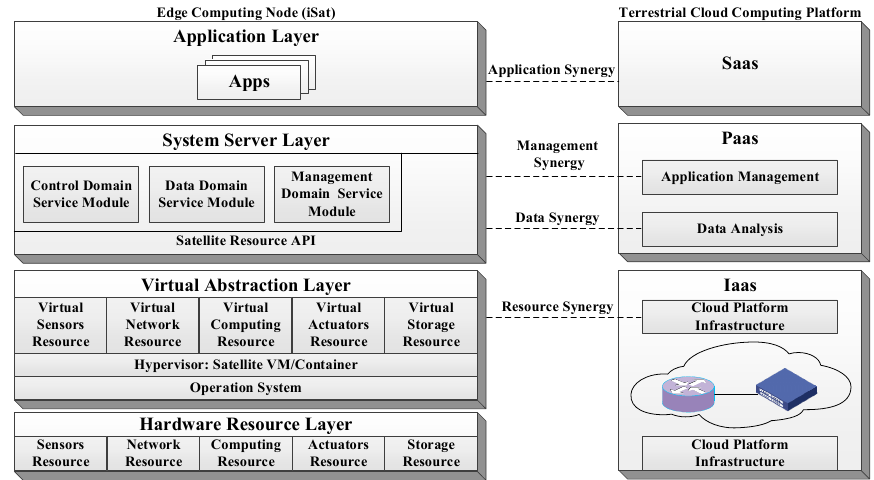
Figure 3. The software architecture and collaborative mode of iSat.